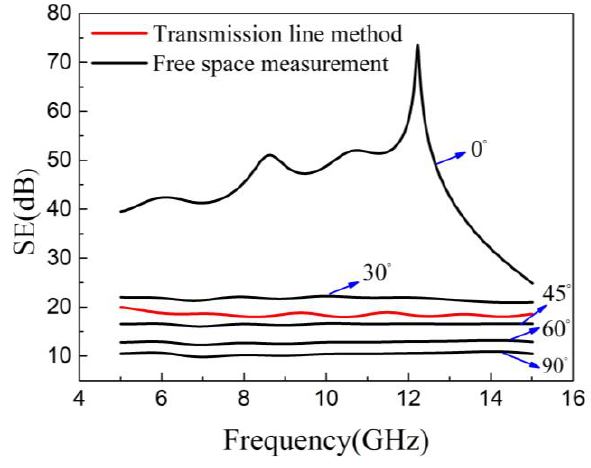
Figure 8. EMI SE of CFRP by the transmission line method and free-space method.